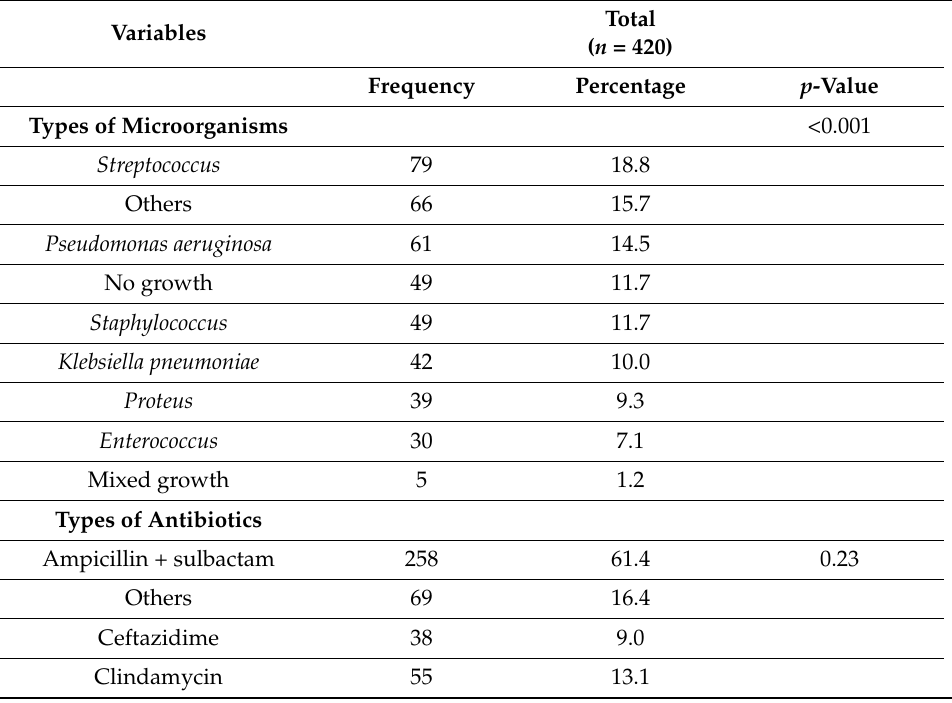
Table 2. Association between amputation, the microorganism and the antibiotics